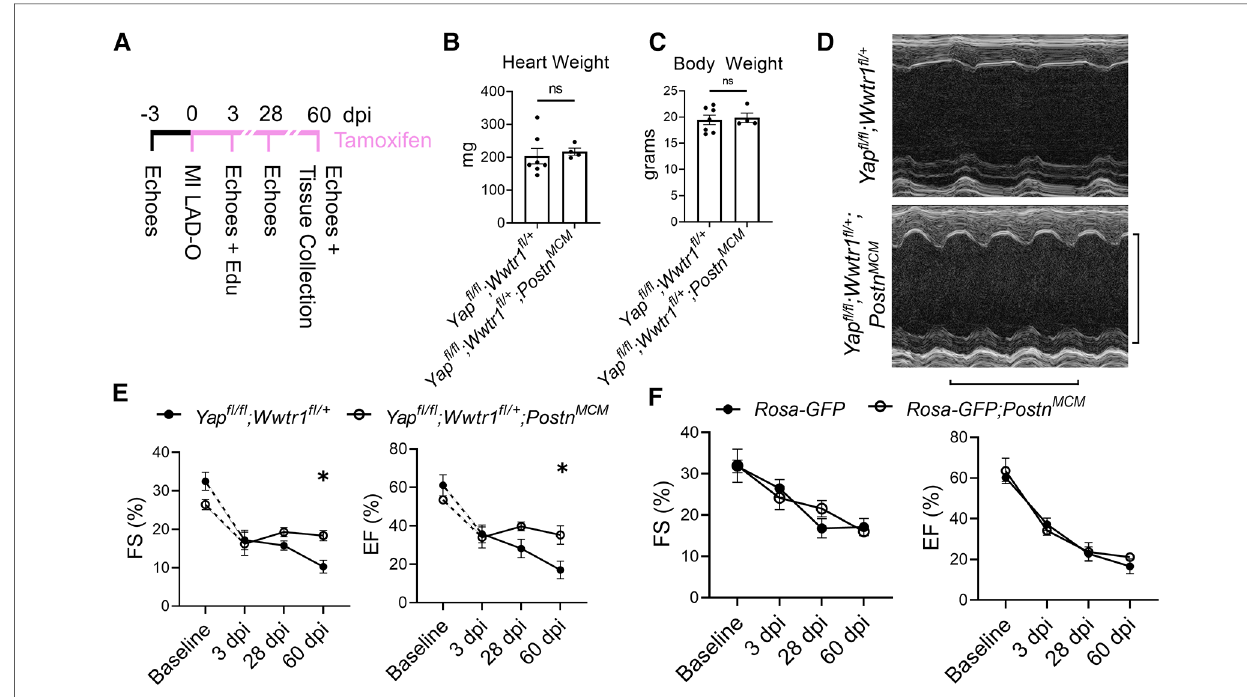
FIGURE 2 Depletion of Yap and a single copy of Wwtr1 from myo fi broblasts improves left ventricular function in response to ischemic injury. ( A ) Experimental timeline of echocardiography, MIs, tamoxifen chow administration, and EdU administration in adult Yap fl / fl ;Wwtr1 fl /+ and Yap fl / fl ;Wwtr1 fl /+ ;Postn MCM mice. Quanti fi cation of ( B ) heart and ( C ) body weights at 60 dpi. n =7 Yap fl / fl ;Wwtr1 fl /+ and 4 Yap fl / fl ;Wwtr1 fl /+ ;Postn MCM . Unpaired student ’ s t -test. ( D ) Representative M-mode echocardiograms of left ventricles 60 dpi. Short axis view at mid papillary muscle. Horizontal bar=500 ms. Vertical bar= 5 mm. ( E,F ) Quanti fi cation of %FS and %EF analyzed by repeated measures two-way ANOVA and Sidak multiple comparisons test. n =7 Yap fl / fl ;Wwtr1 fl / + , 4 Yap fl / fl ;Wwtr1 fl /+ ;Postn MCM , 5 R26-eGFP f/+ , 4 R26-eGFP f/+ ;Postn MCM . A separate subset of animals establishing a baseline for Yap fl / fl ;Wwtr1 fl /+ animals as denoted by the hashed lines and assessed by un-paired student ’ s t -test. n =4 Yap fl / fl ;Wwtr1 fl /+ and 5 Yap fl / fl ;Wwtr1 fl /+ ;Postn MCM . ns=not signi fi cant, * P